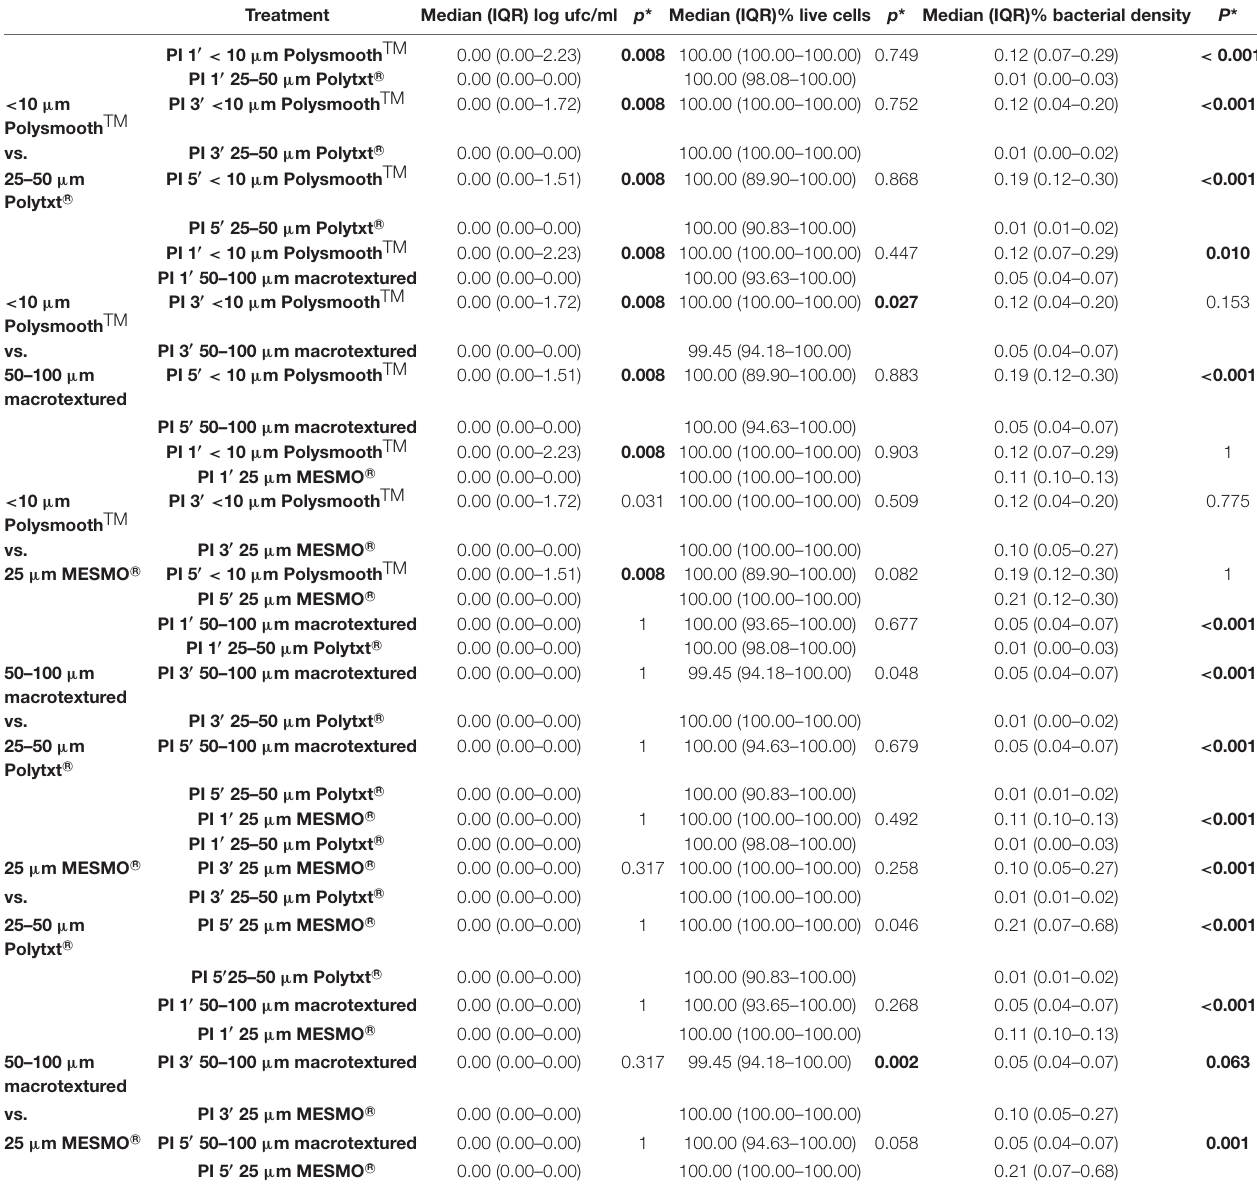
TABLE 4 | Comparative results for povidone iodine at three times of exposure according to Polytech R (cid:13) implants.